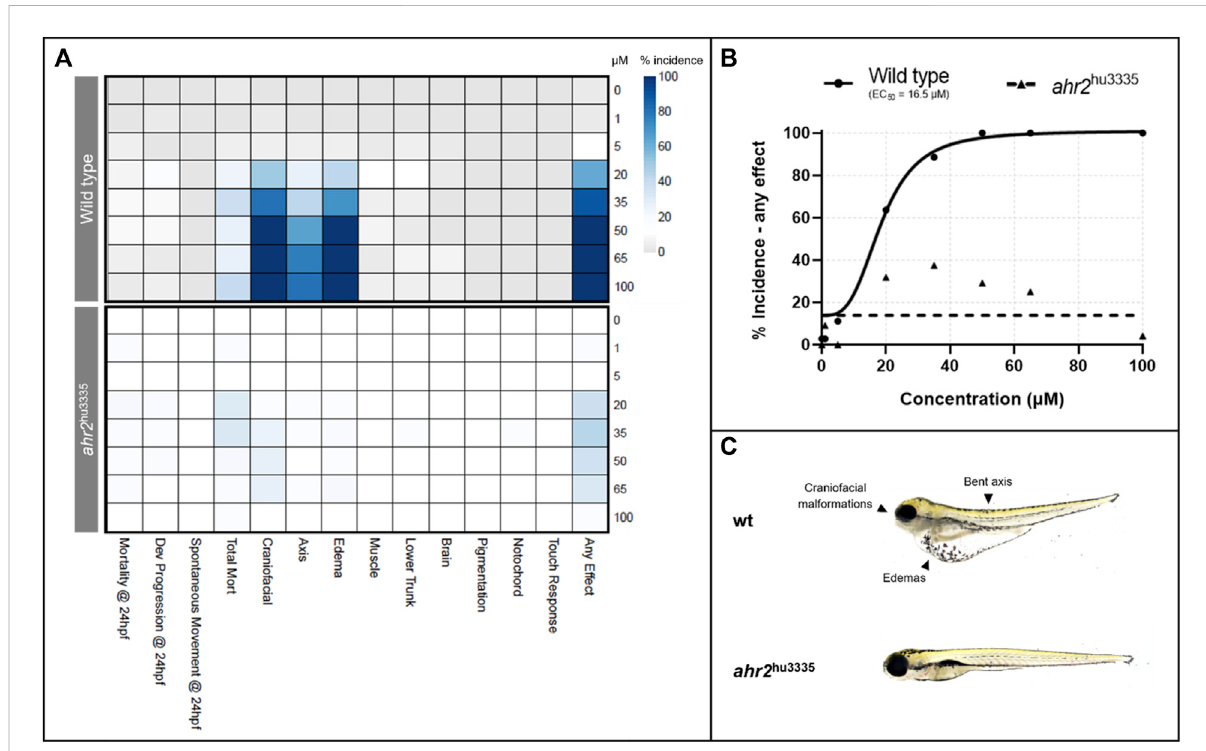
FIGURE 1 Effects of retene exposure on zebra fi sh development at 24 and 120 hpf in wild type and AHR2 mutant fi sh. (A) heatmap of endpoint incidence. Depth of color indicates percent incidence ( x -axis) at given concentration ( y -axis); (B) concentration-response curves for percent incidence of teratogenicity at 24 or 120 hpf; (C) 120 hpf larvae resulting from exposure to 50 µM retene beginning at six hpf, with and without functional AHR2.